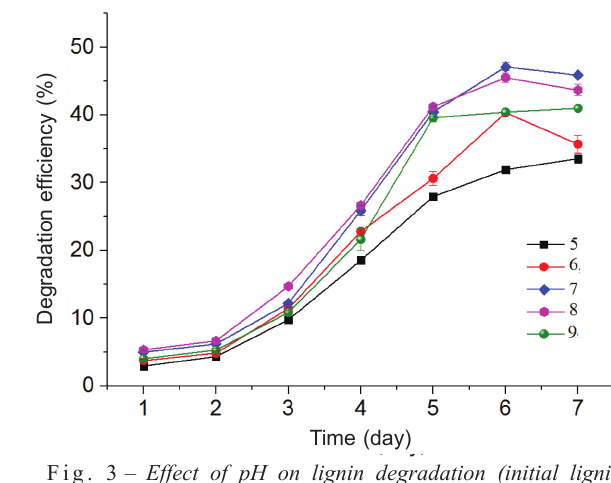
Fig. 3 – Effect of pH on lignin degradation (initial lignin concentration = 1 g L –1 , shaking speed = 120 rpm,